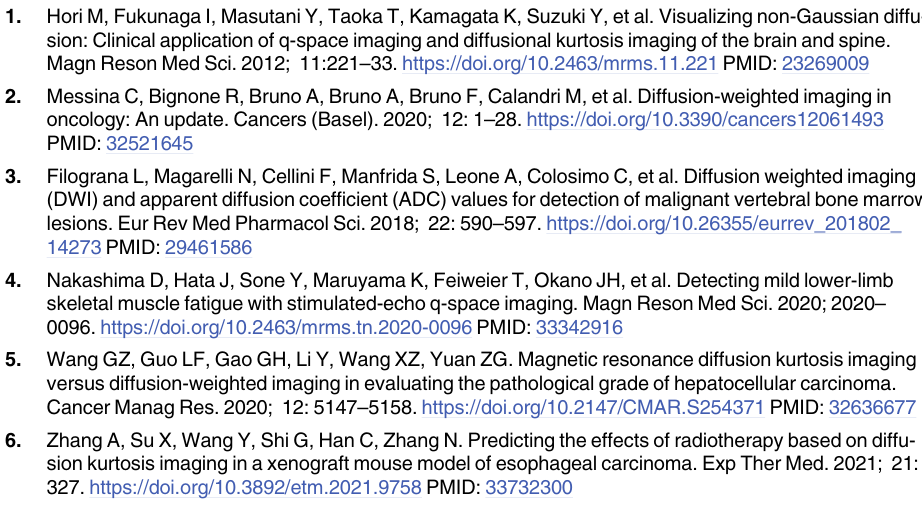
S2 Dataset. Dataset for Fig 4. S3 Dataset. Dataset for Fig